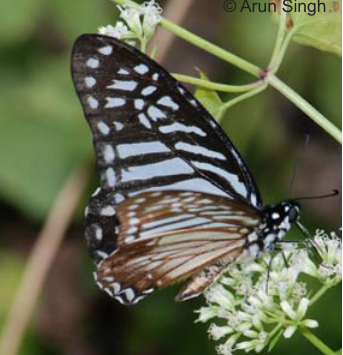
Image 14. Five bar Swordtail Graphium antiphates pompilius